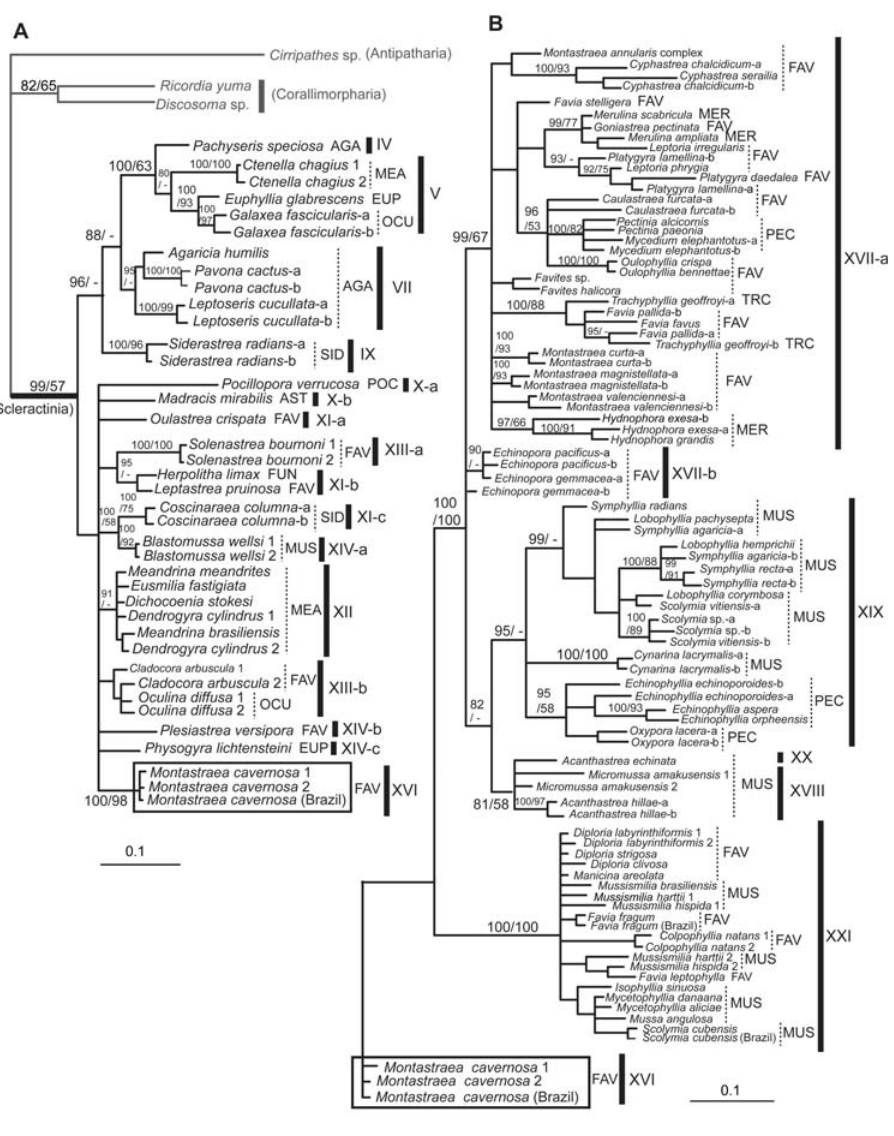
Figure 2. Bayesian tree based on the tubulin gene for a subset of corals shown in Fig. 1. Letter (a, b) after species names indicates that different alleles were obtained from a single coral sample; see Fig. 1 legend for other labeling conventions. A. Phylogenetic relationships among complex corals and some robust corals. B. Phylogenetic relationships within robust corals. Note that the same data for the Montastraea cavernosa clade (in box) were used in both